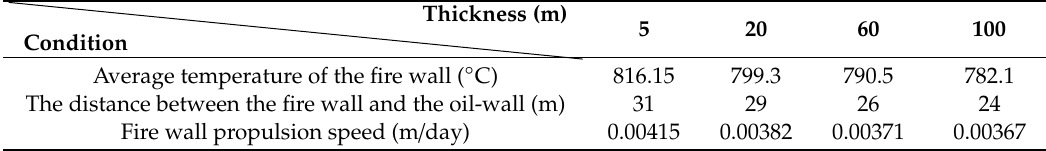
Table 20. Characteristic parameters of fire wall under di ff erent formation